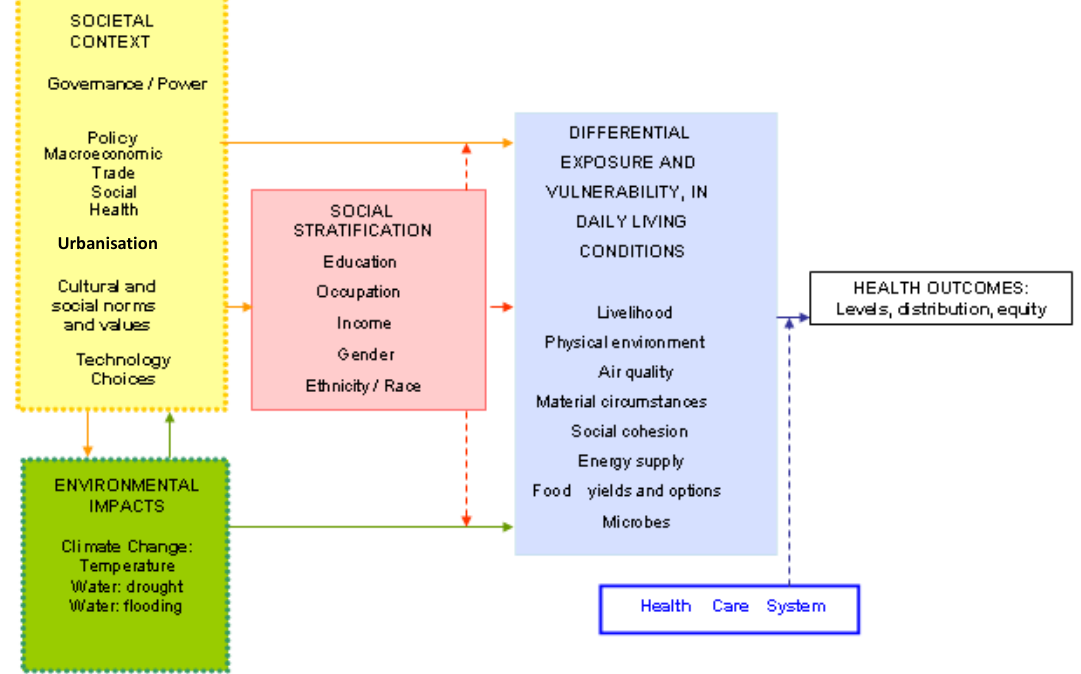
Figure 1. The relationships between climate change, social determinants and health inequity (note solid lines indicate causal pathways and dotted lines indicate effect modifiers)